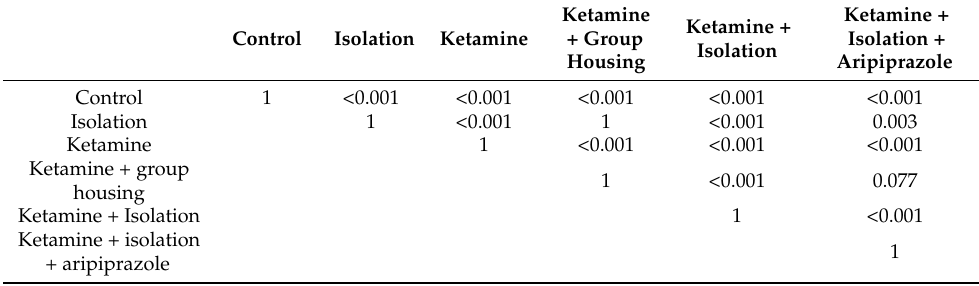
Table 11. All p -values following the post hoc comparison for the level of SOD in the